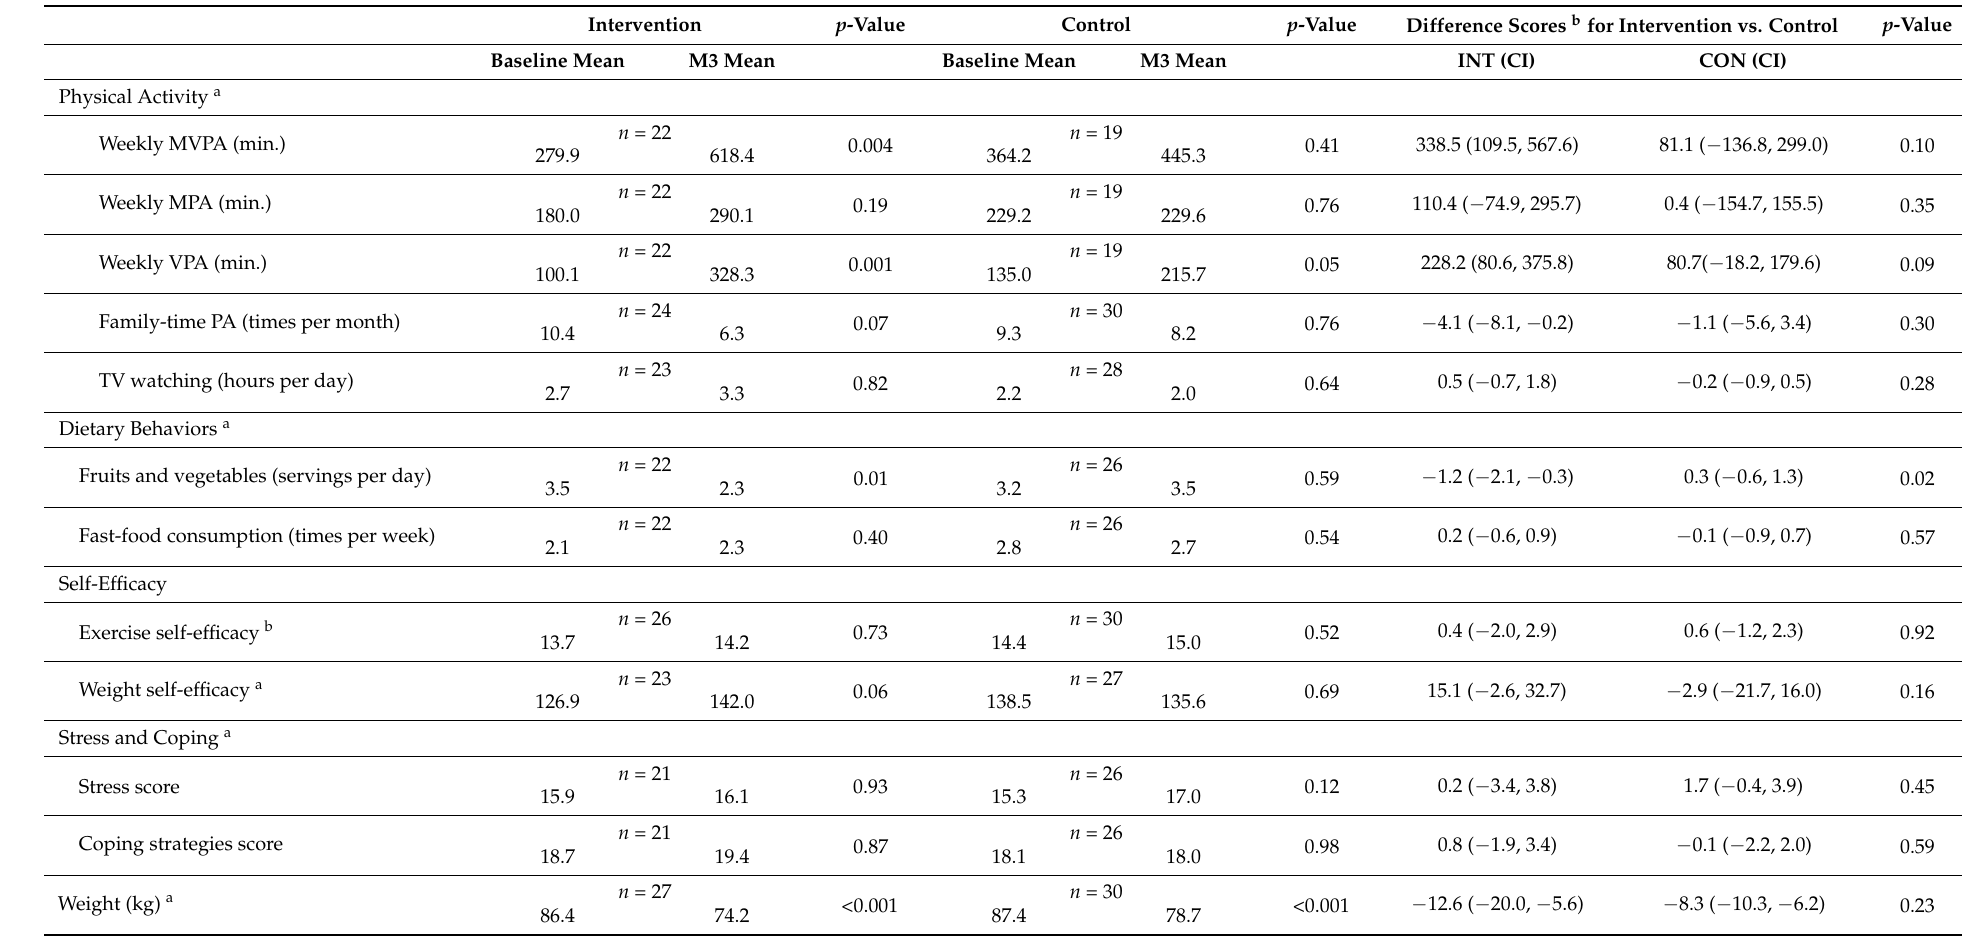
Table 3. Change in outcomes from baseline to